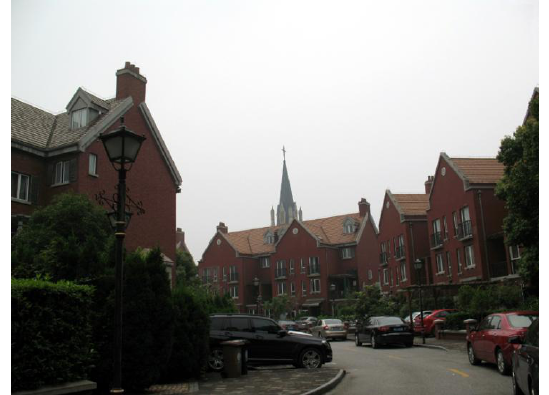
Figure 24. Shanghai Thames Town residential quarters in the Songjiang County imitating the Olde England. Photo: Donia Zhang